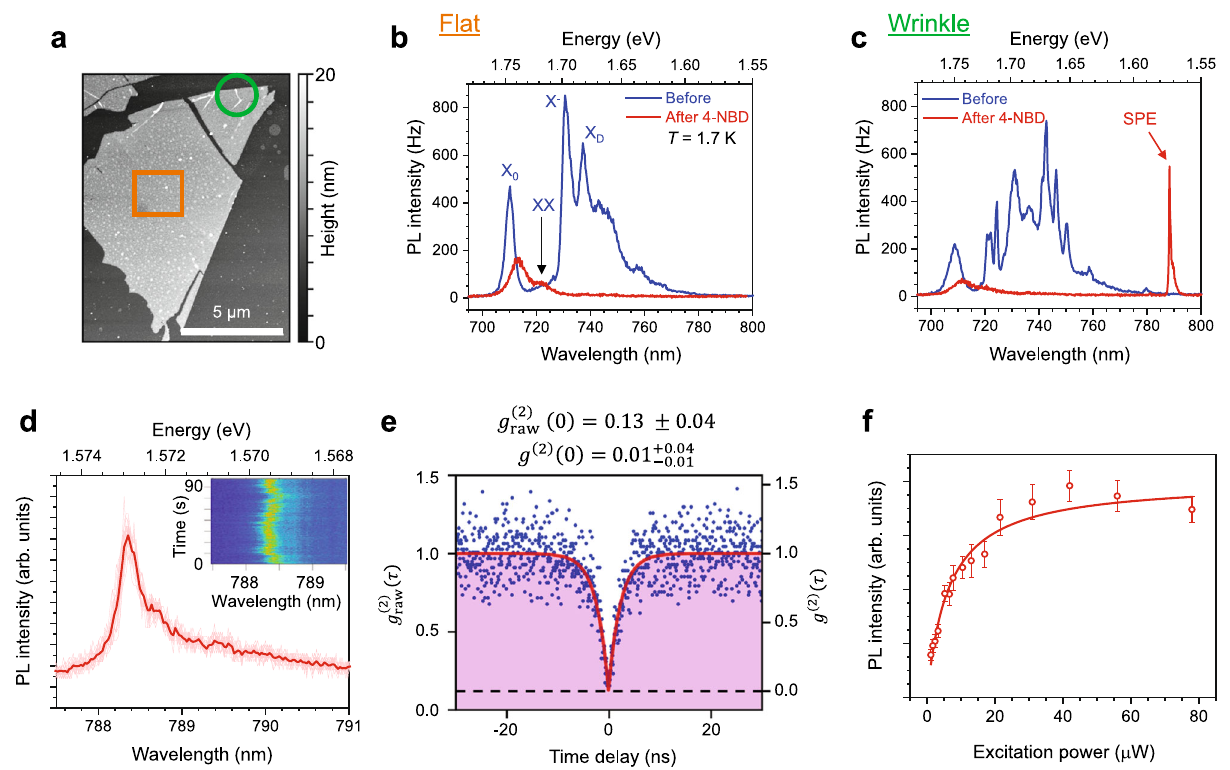
Fig.2|Partialquenchingofdefectemittersinlocallystrained1LWSe 2 .a Height image from atomic force microscopy (AFM) of a 1L WSe 2 fl ake. The region marked with the orange square is relatively fl at, whereas the region inside the green circle contains wrinkles with localized strain. b , c Low-temperature ( T =1.7K) photo- luminescence (PL) spectra of 1L WSe 2 at ( b ) the fl at region and ( c ) the wrinkle, before (blue) and after (red) 4-nitrobenzenediazonium (4-NBD) treatment. The spectrawere measured with ~60 µ W excitation power. d High-resolution spectrum of the single-photon emitter (SPE) from ( c ). The thick red trace is the time average of the traces shown in pink. Inset: SPE spectral diffusion plot. e Second-order